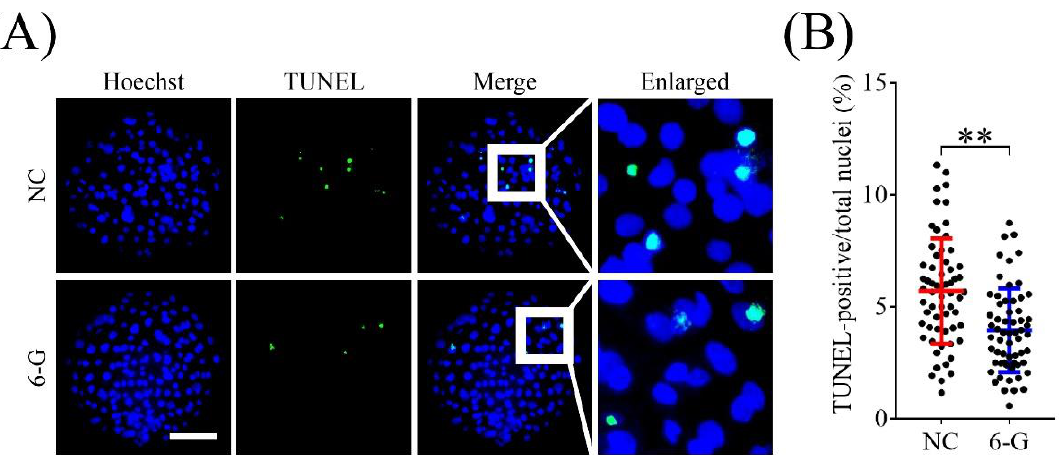
Figure 3. Effects of 6-gingerol (6-G) on cell apoptosis in blastocysts. ( A ) Representative staining im- ages of Hoechst and terminal deoxynucleotidyl transferase-mediated dUTP-biotin nick end-labeling (TUNEL) of blastocysts. Bar = 100 μm. ( B ) Apoptotic rates in blastocysts with or without 6-G treatment. R = 5. ** p < 0.01.